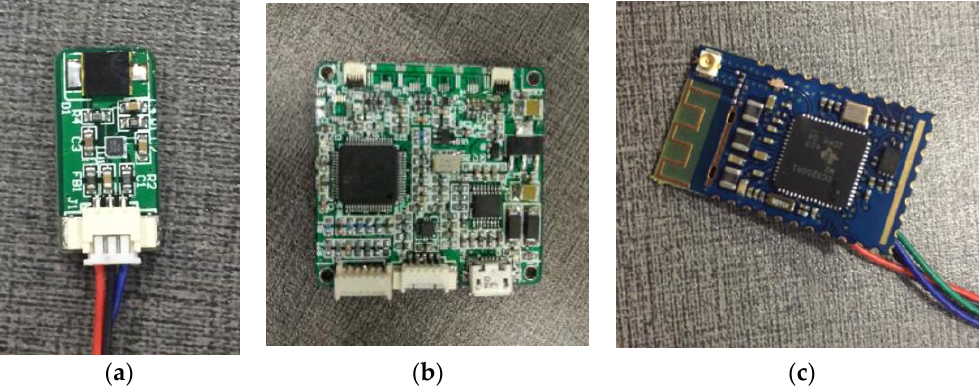
Figure 3. Hardware prototype. ( a ) Prototype of receiver; ( b ) Prototype of processing unit; ( c ) Convert Serial port to Wi-Fi.